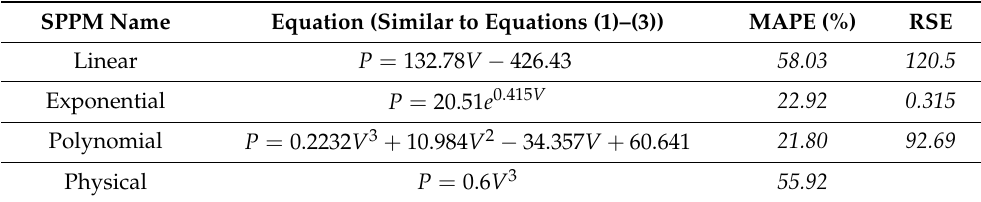
Table 3. Summaries for SPPM mean absolute percentage and residual standard error (MAPE and